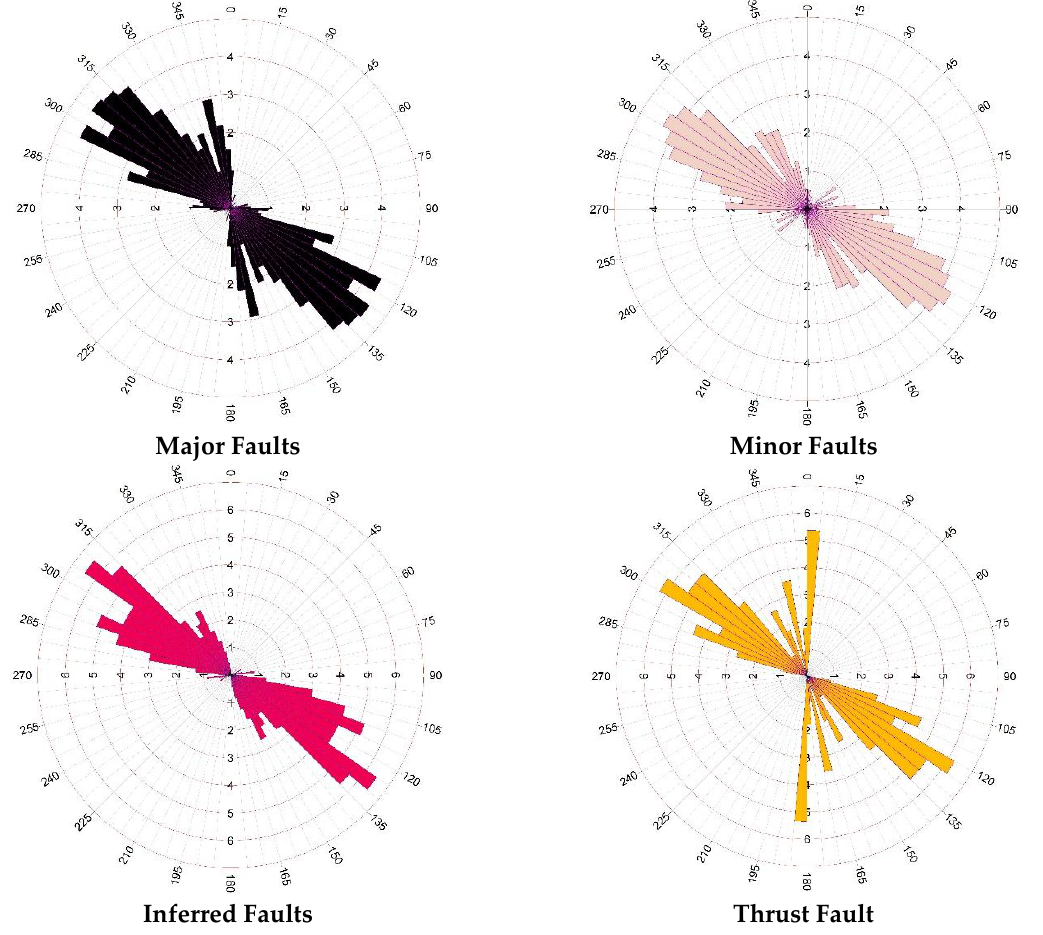
Figure 4. Rose diagram of faults by each of the types in the study area. The exact locations of the faults according to the colors assigned in the rose diagrams are shown in Figure 8 as a map.